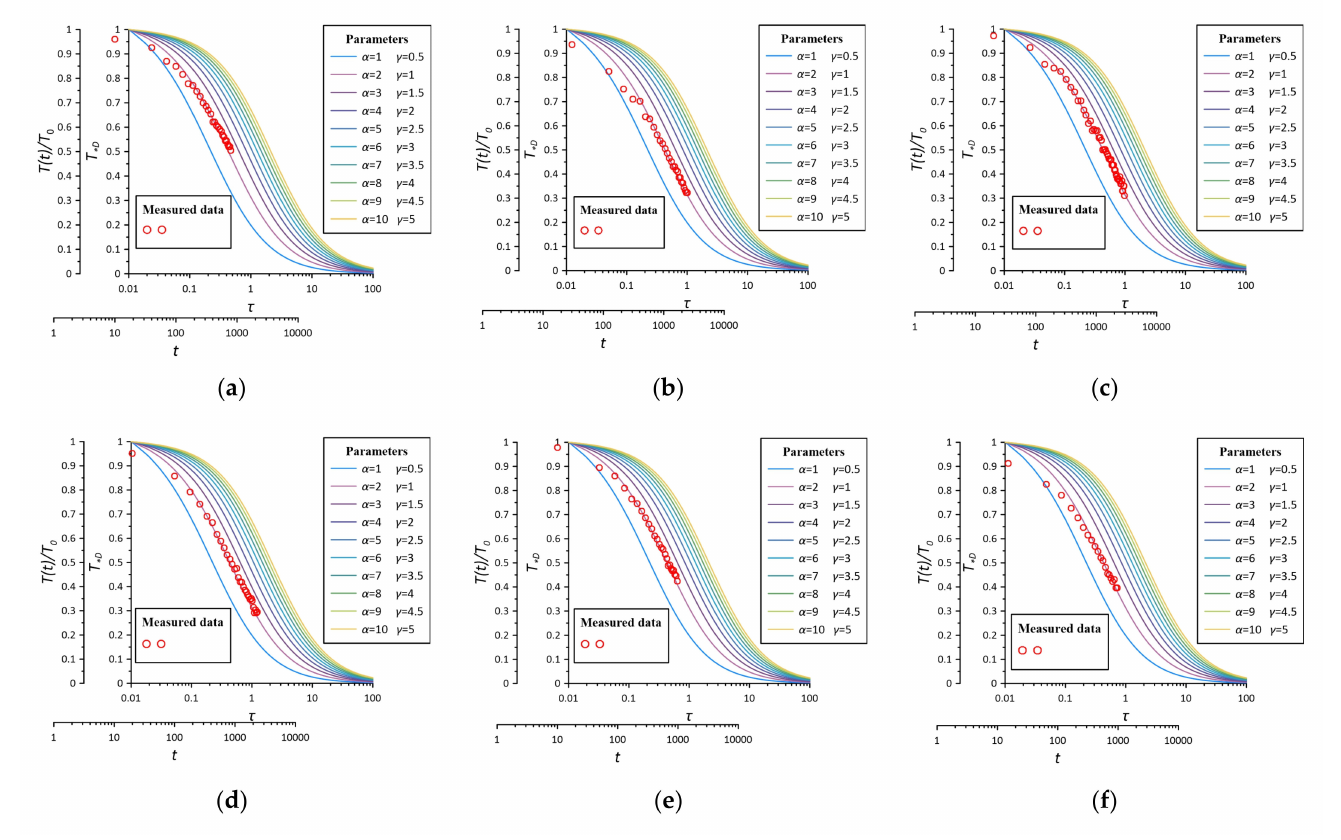
Figure 7. Matching diagram for different excitation strengths in the test well in the case of u = 0. ( f ) w ( ∆ T = 10 ◦ C ) 2. Table 2. Calculation results of the thermal property parameters of the aquifer by the slug heat test method in the case of u =